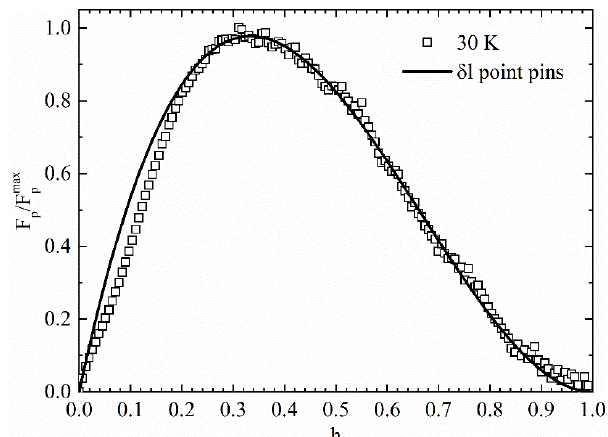
Figure 7. Normalized pinning force density as a function of the reduced magnetic field h = H/H irr at T = 30 K fitted with Equation (4). Fit details are reported in the text.